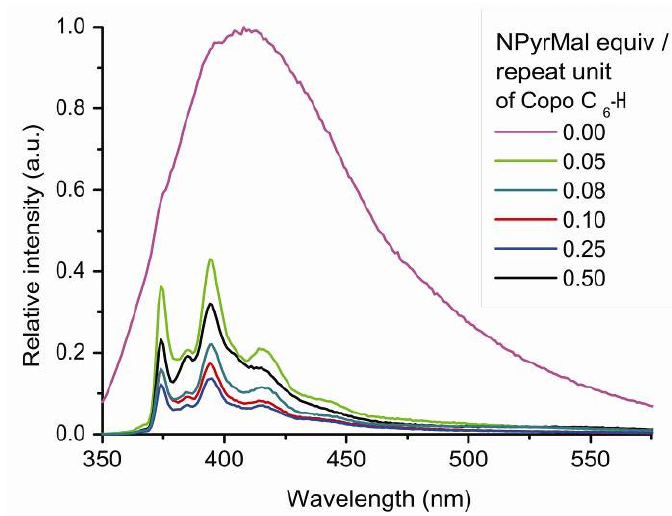
Figure 7. Photoluminescence spectra (emission mode, excitation at 340 nm) of “host-guest” materials Copo C -H/NPyrMal in the solid state. 6